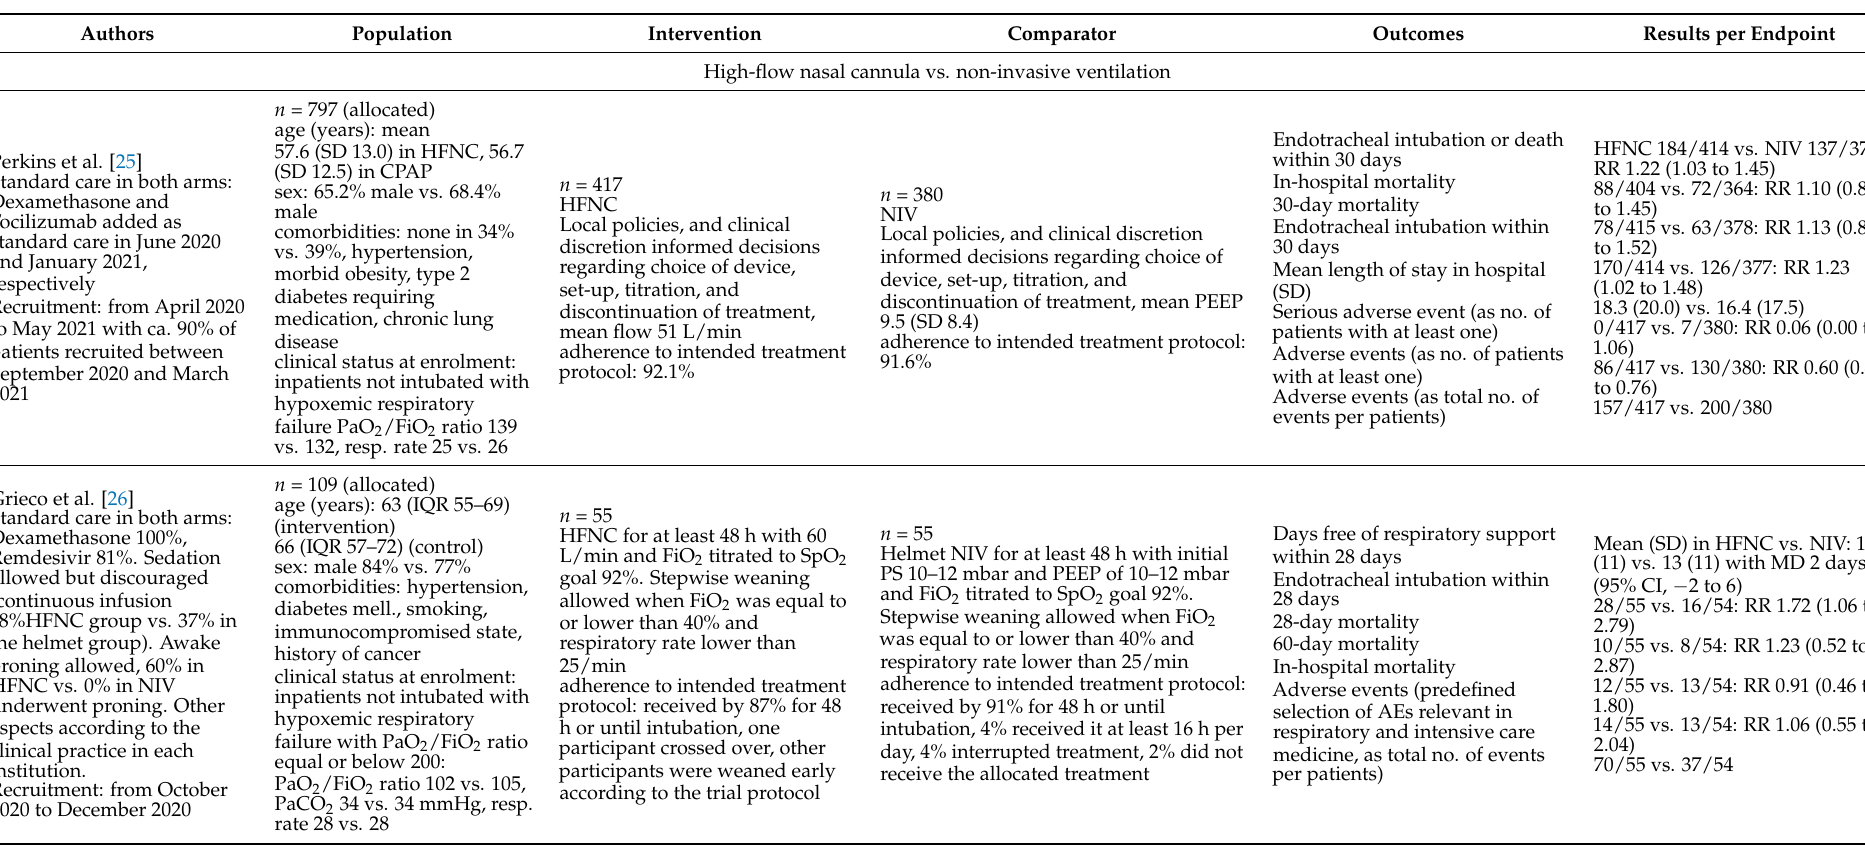
Table 1. Study characteristics. AE: adverse event, APP: awake prone-positioning, CPAP: continuous positive airway pressure, F i O 2 : inspiratory fraction of oxygen, HFNC: high-flow nasal cannula, ICU: intensive care unit, IQR: inter-quartile range, NIV: non-invasive ventilation, PaCO 2 : carbon dioxide partial pressure, P a O 2